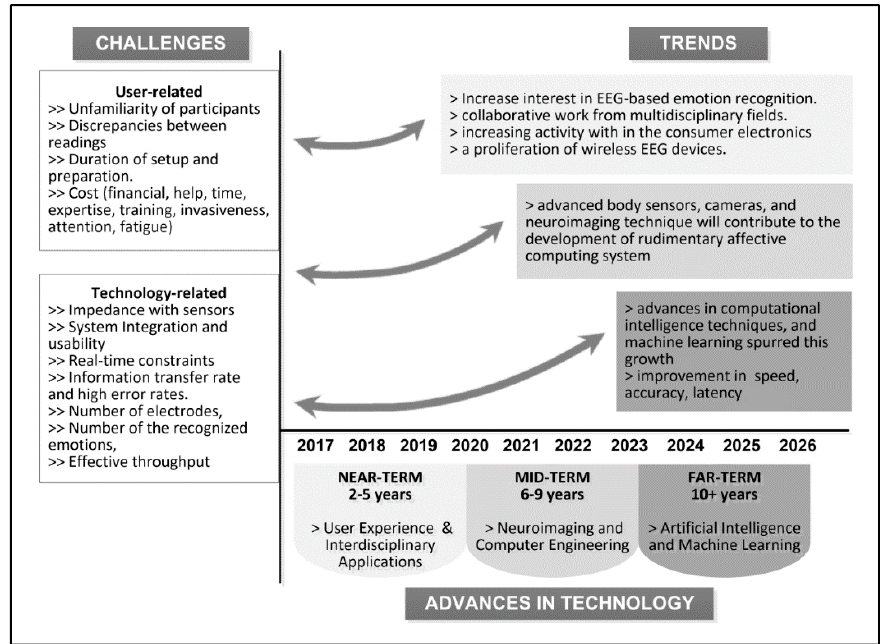
Figure 6. Challenges and future directions.